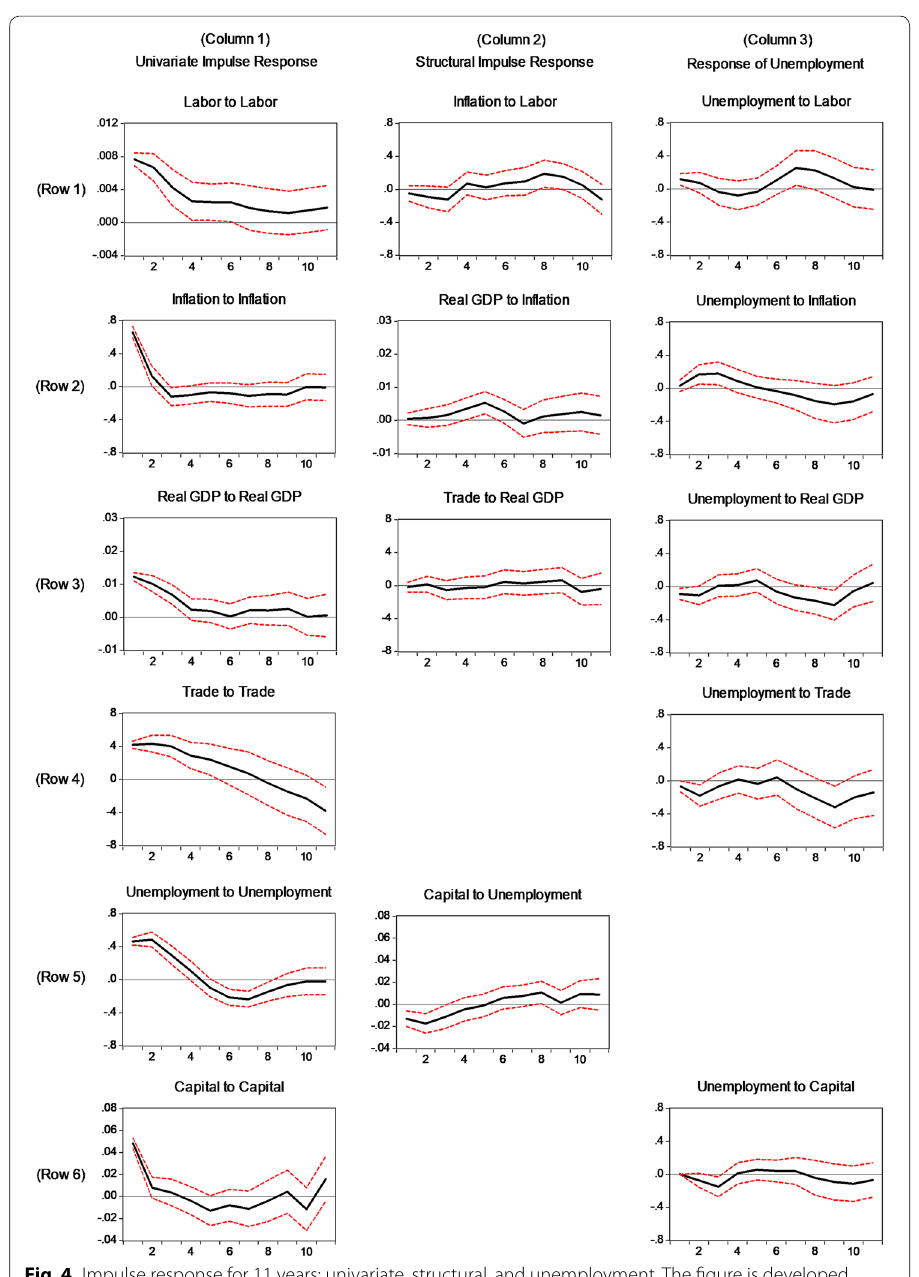
Fig. 4 Impulse response for 11 years: univariate, structural, and unemployment. The figure is developed using EViews (version 8) VAR and Cholesky decomposition method for impulse response. Each sub-figure shows the degree of response to one Cholesky standard-deviation shock ( the dash